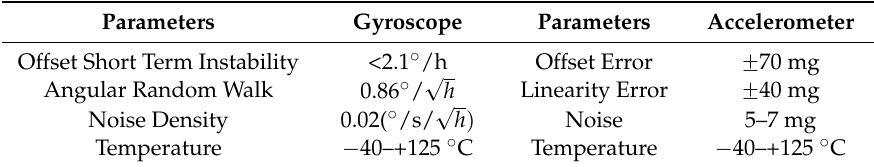
Table 1. SCC1300-D04 Performance.